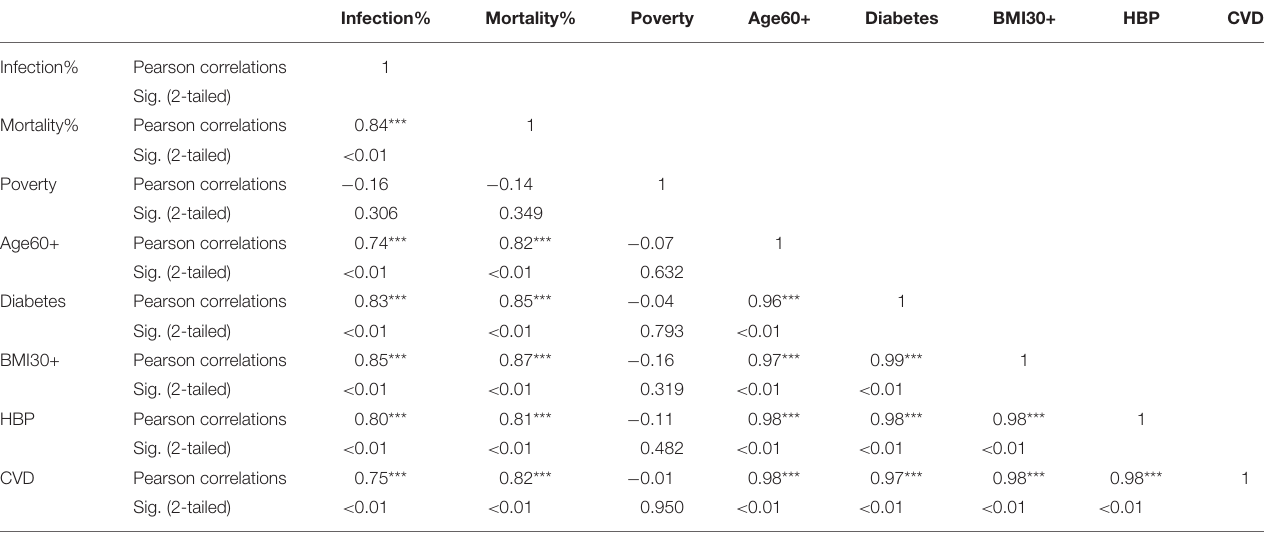
TABLE 5 | Pearson correlations for Hispanic ethnic group between variables used in the study and their significance levels.